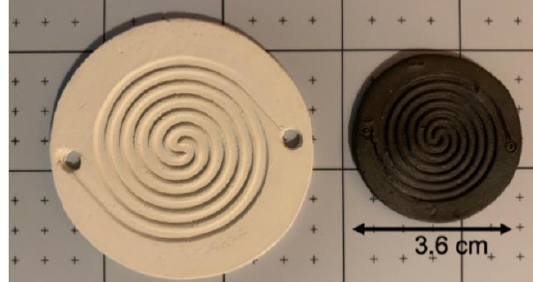
Figure 2. BZCY755 molded spiral channel green ( left ), fired ( right ).